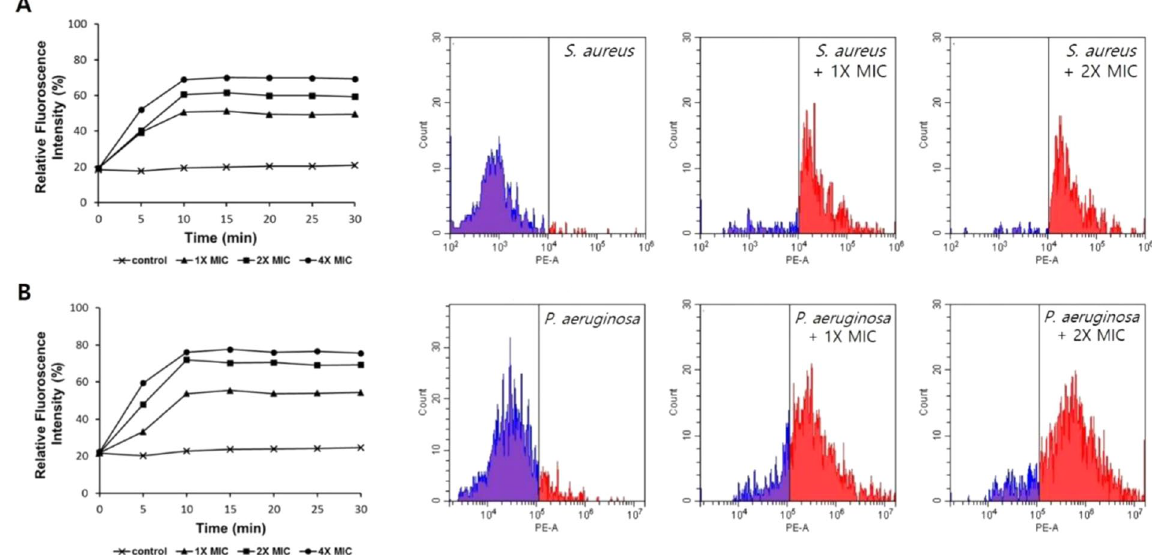
Figure 6. PI uptake assay and flow cytometric analyses of increases in PI fluorescence intensity after treatment with melectin. ( A ) S. aureus ATCC 25923, ( B ) P. aeruginosa ATCC 27853.